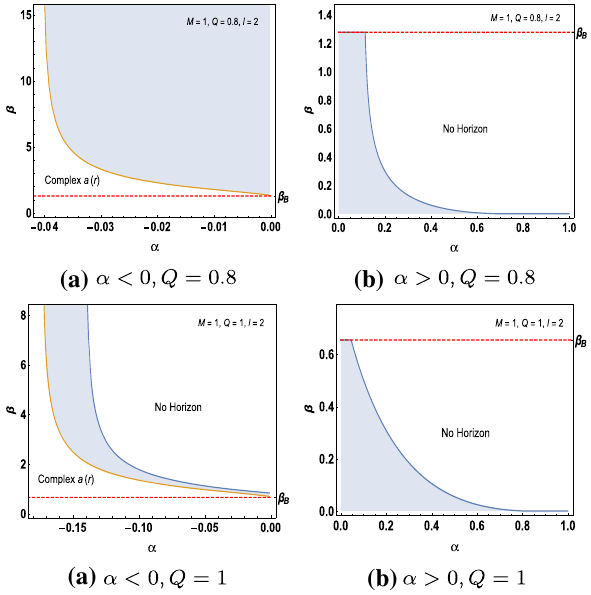
Fig. 2 The parameter space for the case of M = 1, Q = 0 . 8 , 1, and l = 2, where the shaded area represents available parameter region (cid:8) 2 β B Q and the Ricci scalar R ≈